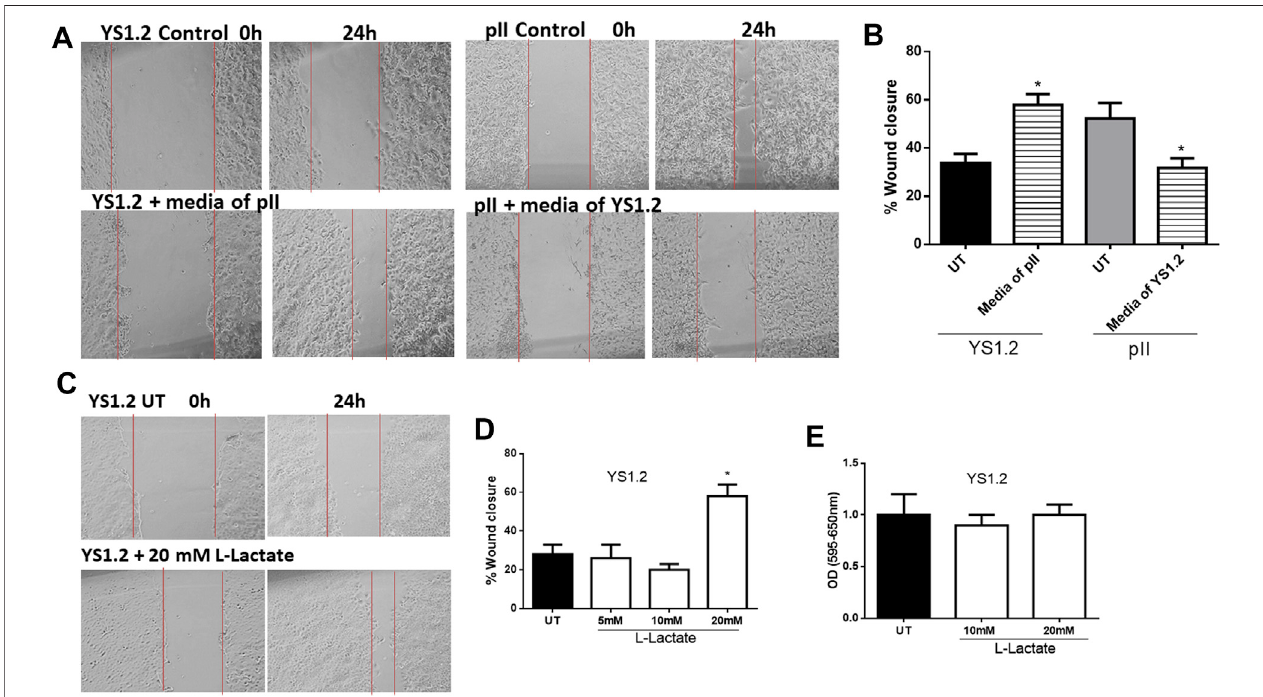
FIGURE5| Effectoflactatesupplementationonbreastcancercellmotility. (A – D) showthepercentageofwoundclosure(usingscratchassay)inpIIorYS1.2using different treatment approaches. * p < 0.05 Vs. UT cells ( n (cid:2) 6 per group). (E) show cell proliferation (using MTT assay) at day 4 ( n (cid:2) 3 per group).